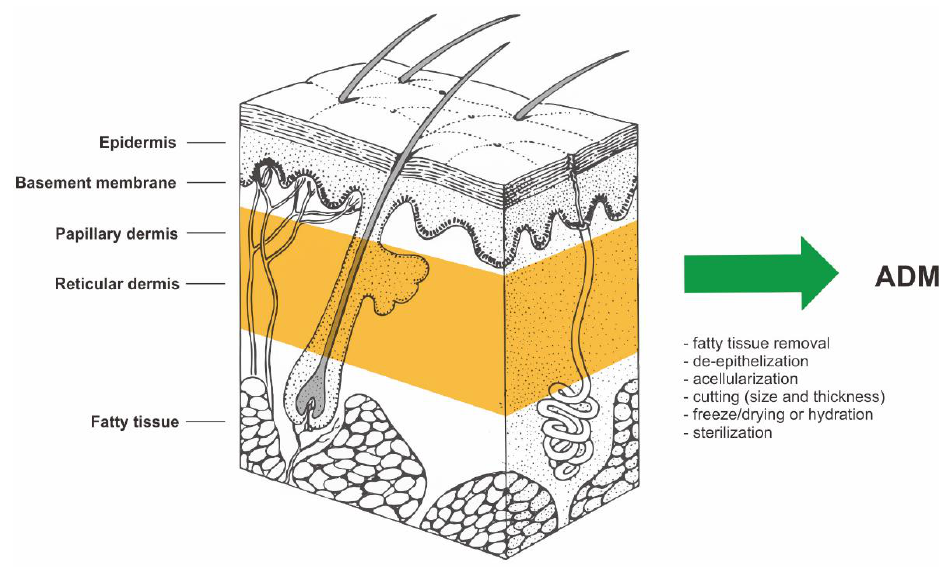
Figure 2. The biological source and the manufacturing process of ADM (acellular dermal matrix). Structure of human skin based on https://visualsonline.cancer.gov/details.cfm?imageid=2496 (access on January 1, 2001 )[10].